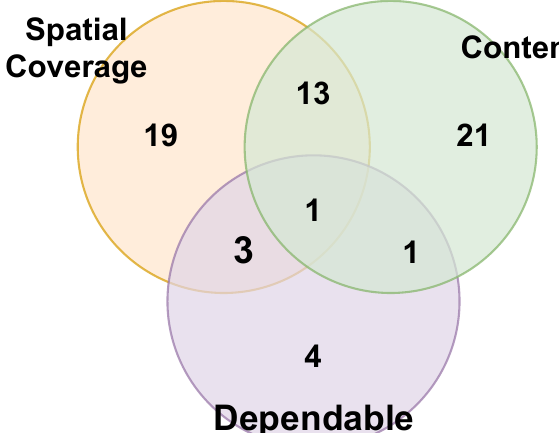
Figure 10. Classification groups.